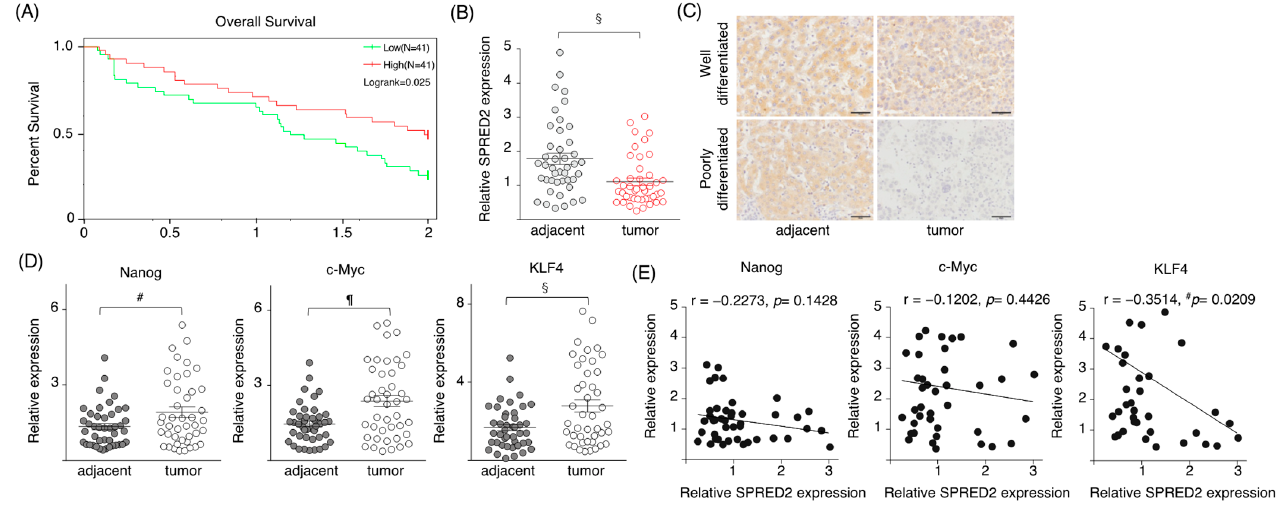
Figure 6. SPRED2 expression in HCC tissues. ( A ) Among 371 HCC cases from TCGA database, 82 cases that could be followed for 2 years, including those who died, were selected. The SPRED2 expression of these 82 cases was dichotomized, and a survival curve was drawn with the high 50% as SPRED2-high and the low 50% as SPRED2-low. ( B – E ) Data from our 40 HCC patients. ( B ) The expression levels of SPRED2 mRNA. ( C ) Representative photos of SPRED2 immunohistochemistry from well and poorly differentiated HCC tissues. Scale bars: 50 µ m. ( D , E ) Expressions of pluripotency factors in HCC tissues. mRNA was extracted from paraffin block. ( D ) The expression levels of Nanog, c-Myc and KLF4 were measured by RT-qPCR. ( E ) The relation between Nanog/c-Myc/Klf4 and SPRED2 was analyzed. # p < 0.05, § p < 0.01, ¶ p < 0.001, two-tailed unpaired t test.